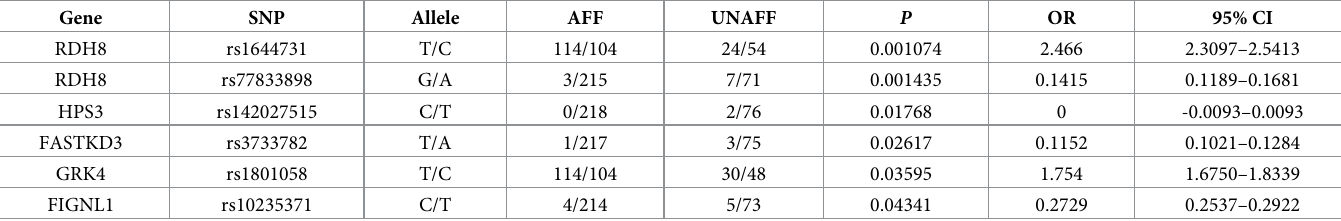
Table 1. SNPs significantly associated with